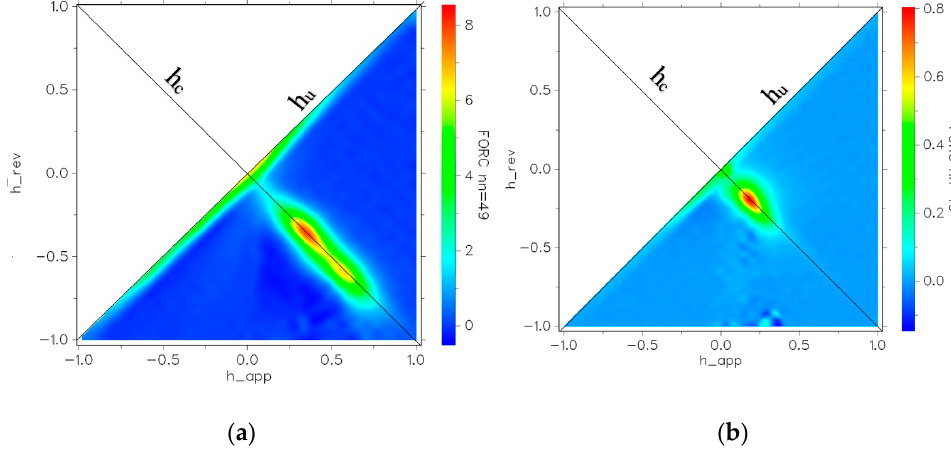
Figure 11. FORC diagrams for CoFe 2 O 4 ( a ) and CoFe 2 O 4 @SiO 2 @Au2 ( b ) nanocomposites. h_rev denotes the applied field for each inversion curve. h_app is the applied field after that inversion is realized. nn is the smoothing factor.